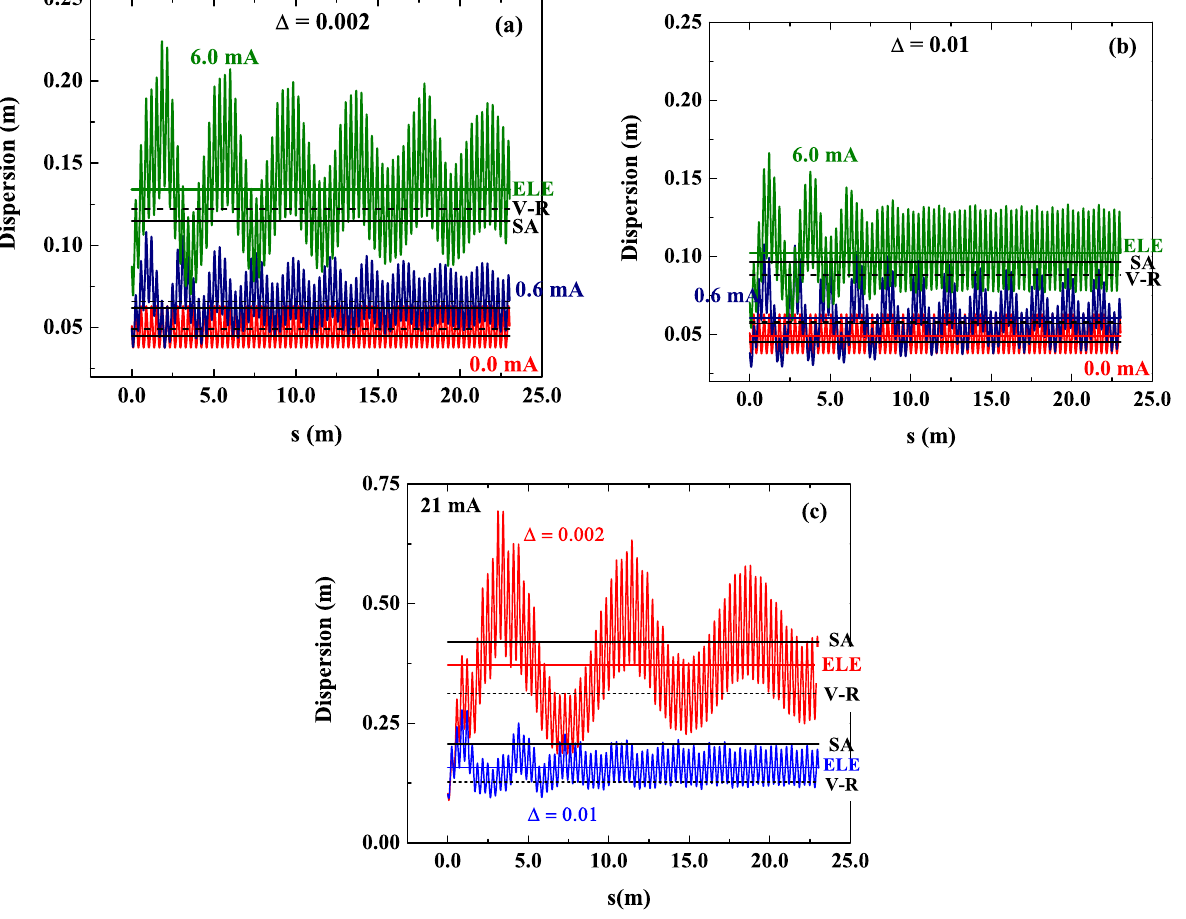
FIG. 4. Dispersion functions with space charge over two turns in UMER from ELEGANT code: (a), (b) 0.0, 0.6, and 6.0 mA at 10 keV; (c) 21 mA at 10 keV. The solid black lines represent results from the smooth approximation [Eqs. (12a)–(12c)], while the broken lines indicate results from the V-R differential equations. Notice the different vertical scale in